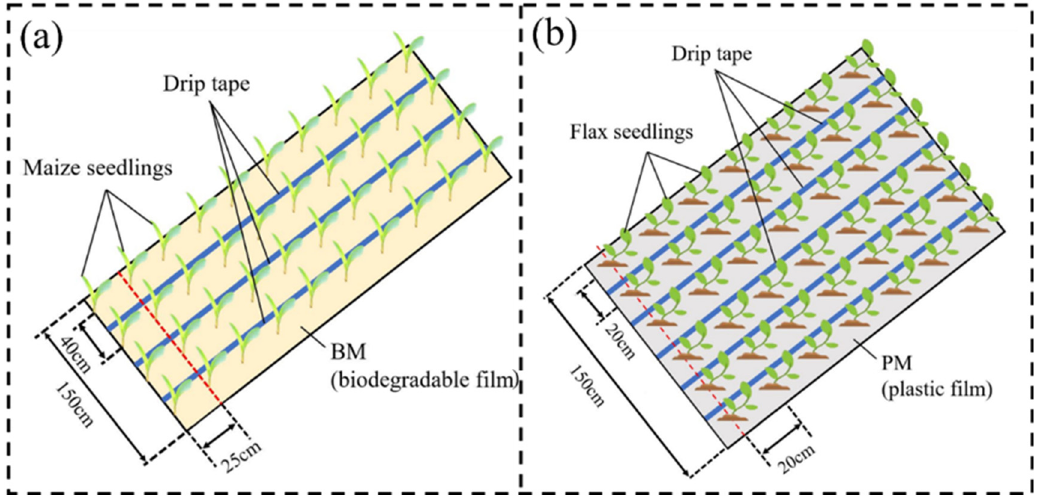
Figure 4. Planting patterns and mulching positions of ( a ) maize and ( b ) flax (biodegradable paper mulch film or white plastic mulch film).